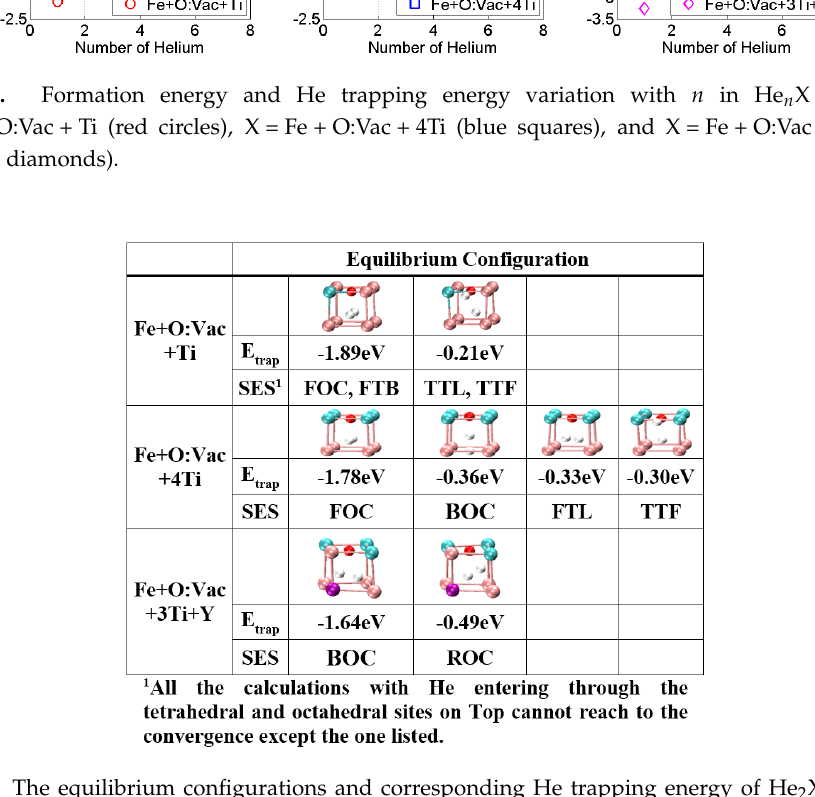
Figure 6. The equilibrium configurations and corresponding He trapping energy of He 2 X clusters with X = Fe + O:Vac + Ti, X = Fe + O:Vac + 4Ti and X = Fe + O:Vac + 3Ti +